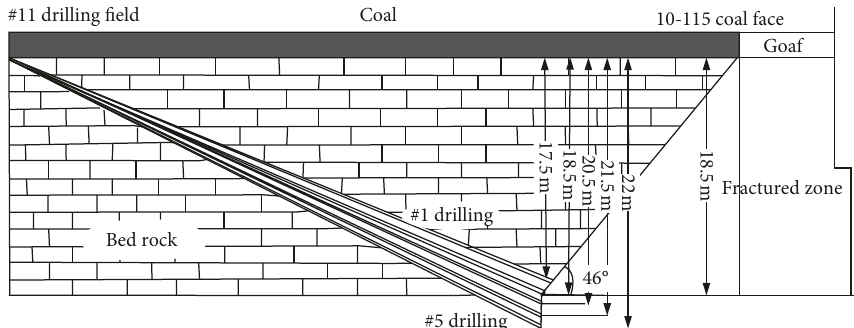
Figure 7: Hole position of water injection experiment and height of the fissure zone of the #11 working